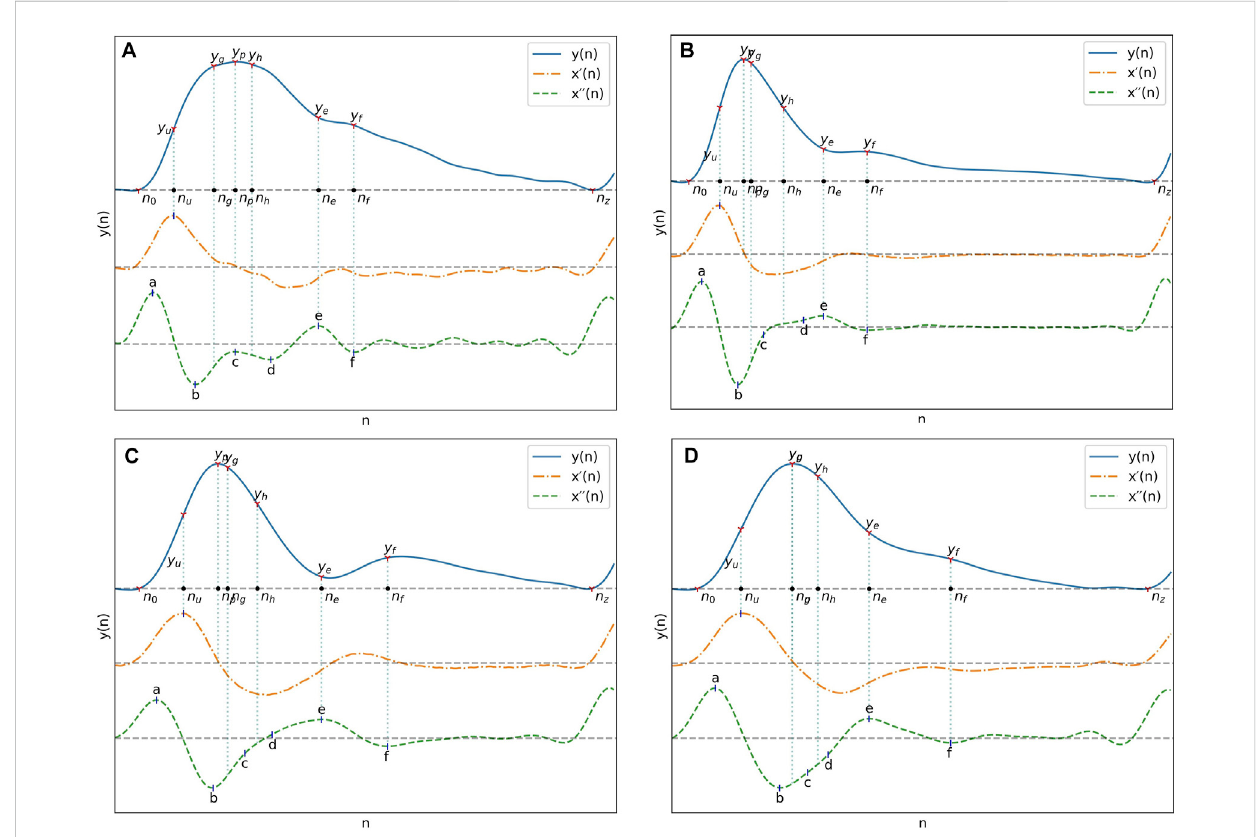
FIGURE 6 (A) Pulse from PPG-BP with characteristics representative of the dataset. (B) , (C) and (D) Pulses from UCI illustrating some of the differences observedwithPPG-BP.Ingeneral,thepulseshapewasmorepointedandnarrower,droppingsharplyafterthepeak.TheamplitudeofthePPGsignalwas